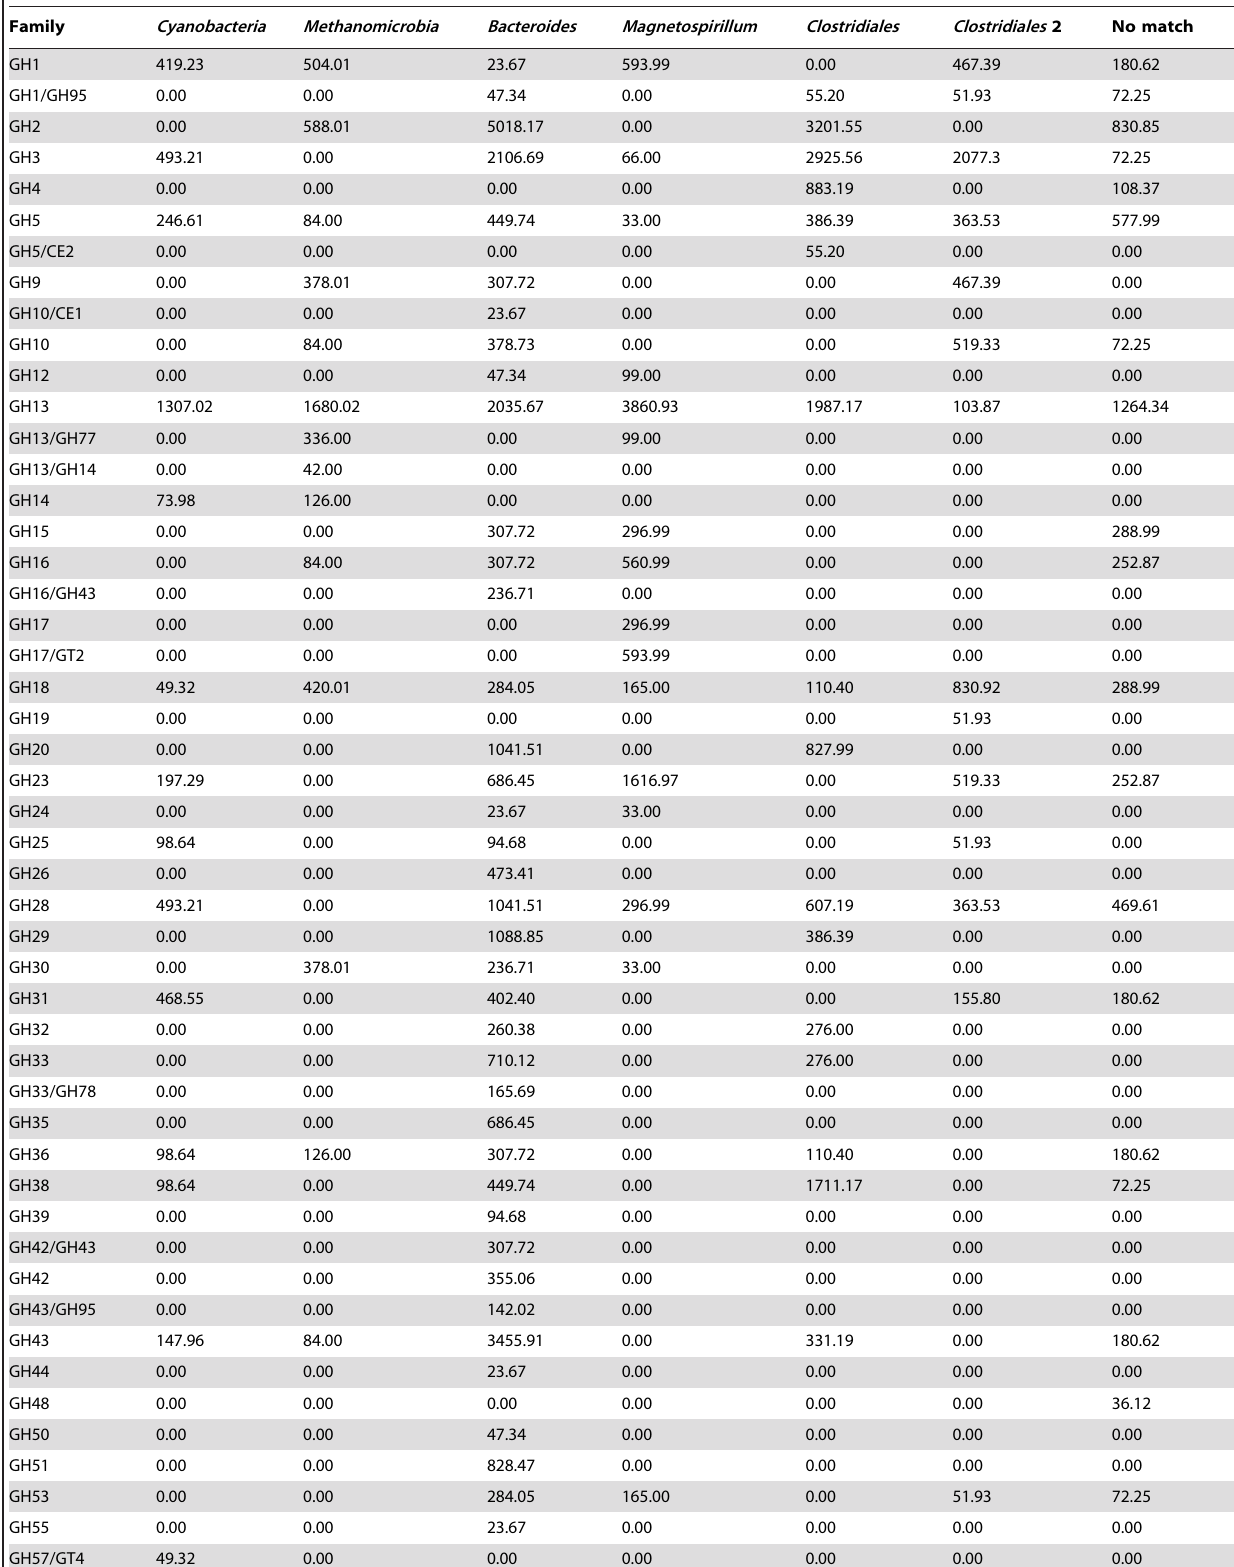
Table 3. Distribution of glycoside hydrolase and lignin peroxidase families over the phylogenetic groups of binned contigs.